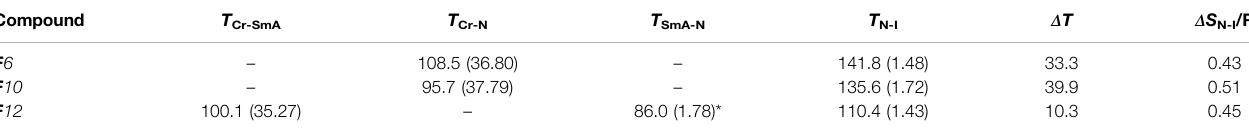
TABLE 1 | Transition temperatures of mesophases, ° C (transition enthalpy Δ H , kJ/mole), mesomorphic range ( Δ T , ° C), and the normalized entropy of transition, Δ S /R, for present series F n. Compound